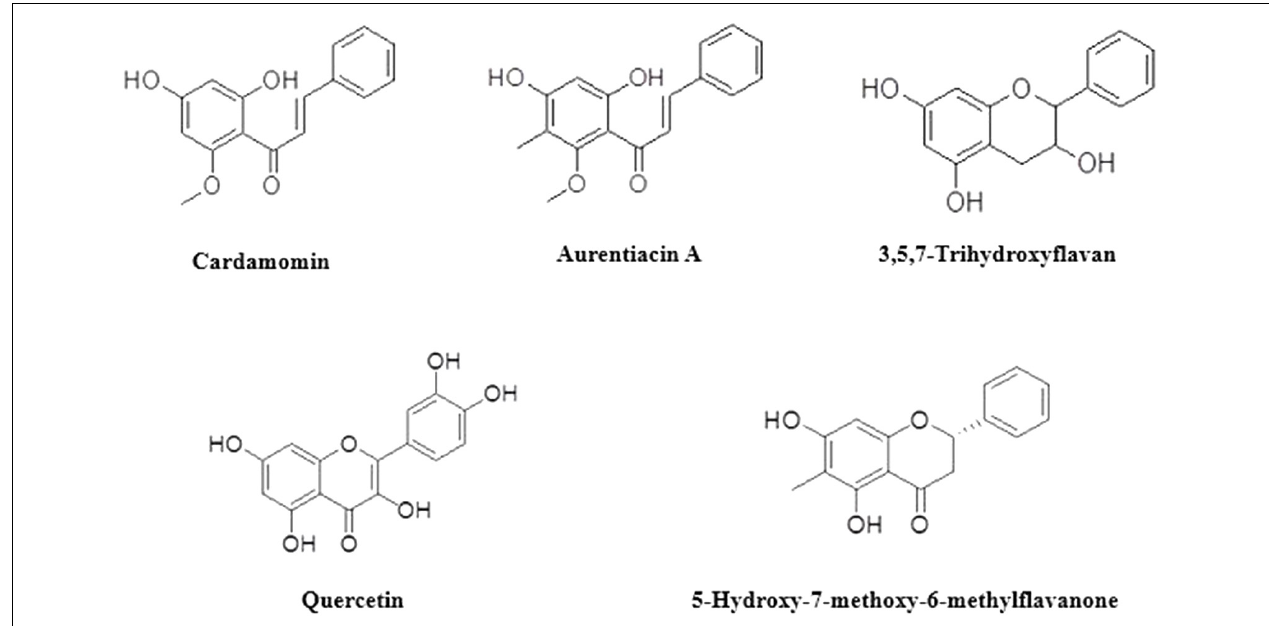
FIGURE 1 | Compounds identified from the